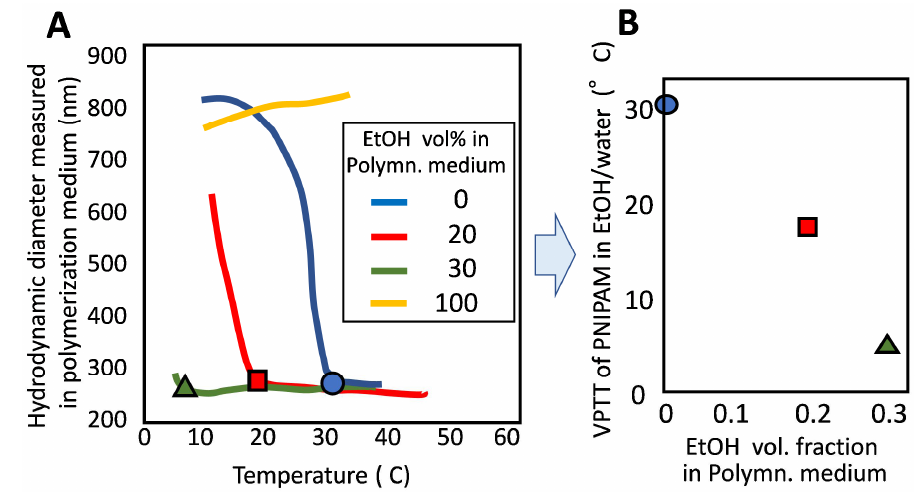
Figure 4. Temperature dependence of hydrodynamic size of microgel in polymerization medium ff erent compositions ( B ( A ), and VPTT of PNIPAM in mixed solvents with different compositions ( B ). and VPTT of PNIPAM in mixed solvents with di